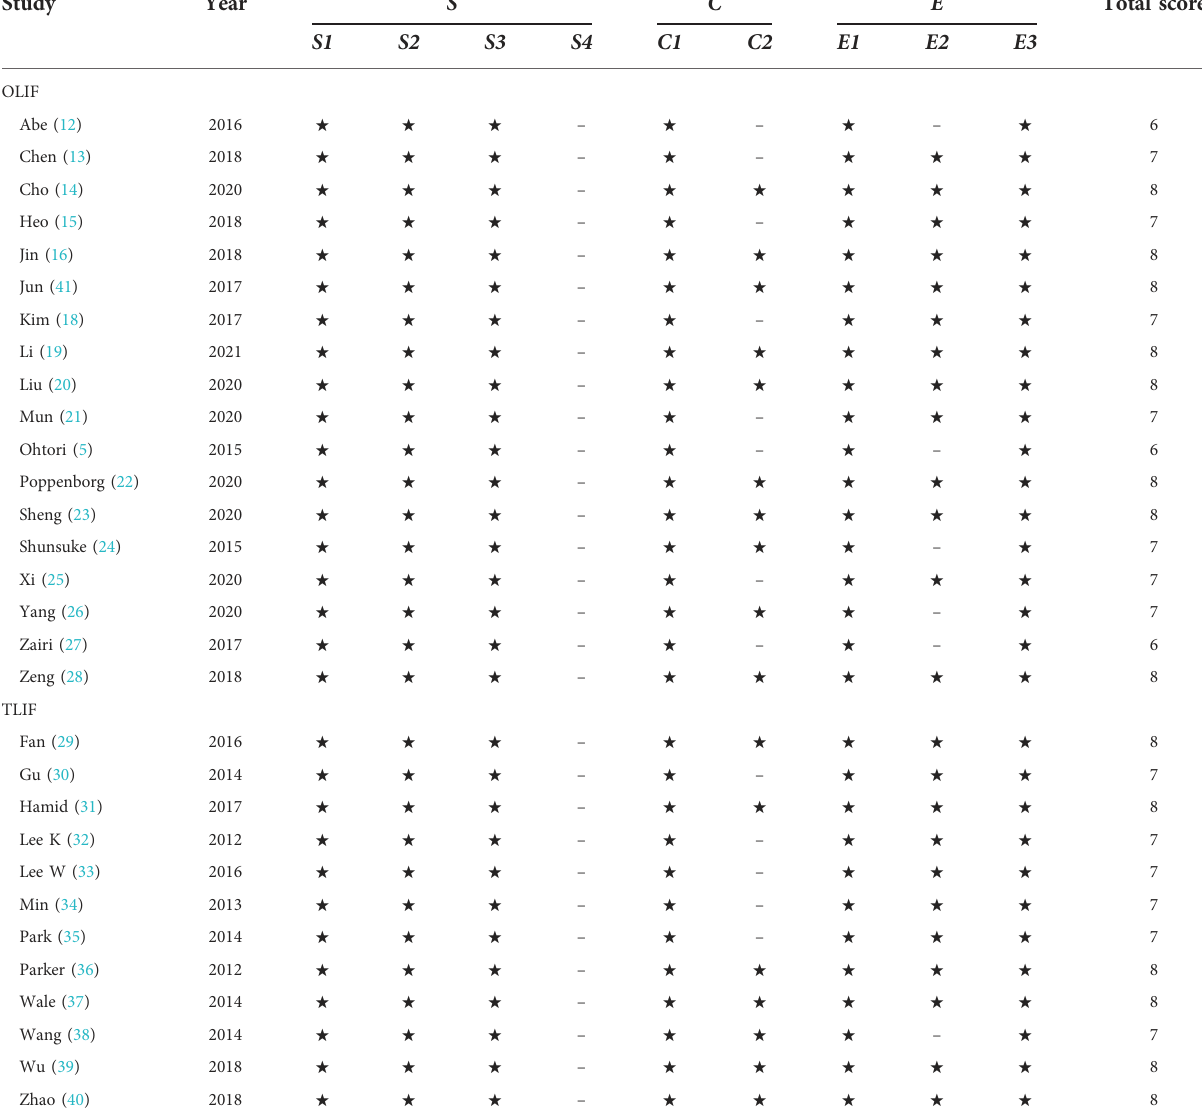
TABLE 3 Quality assessment for the included studies according to Newcastle-Ottawa scale (NOS).